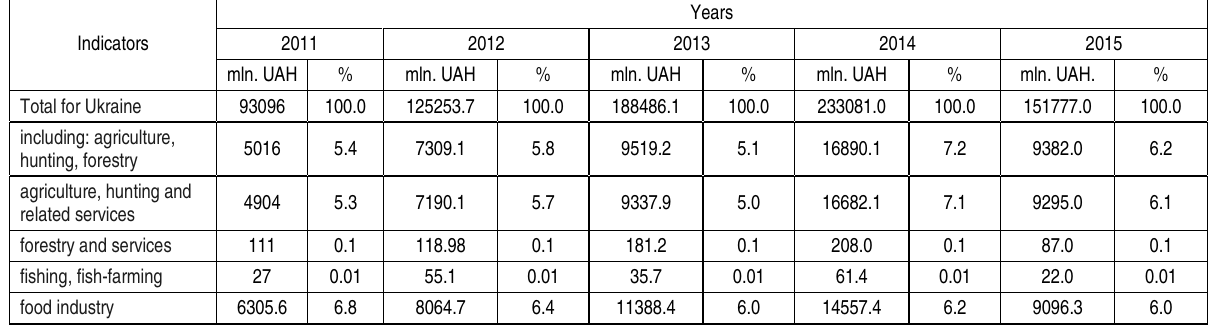
Table 5. Investments into fixed assets of the agricultural sector, 2010-2015 (at the beginning of the year)